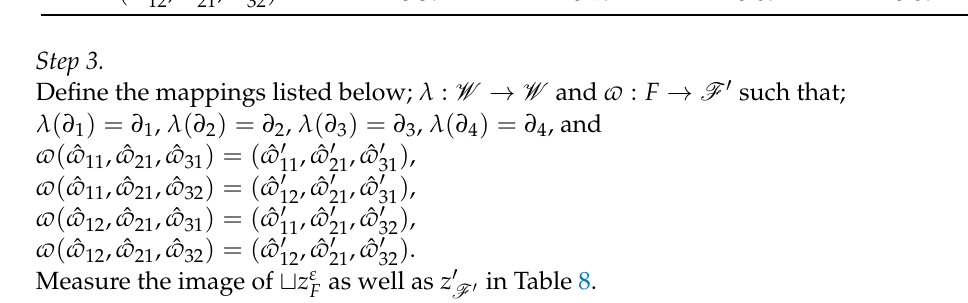
Table 8. z (cid:48) F (cid:48) : The image of (cid:116) z ε